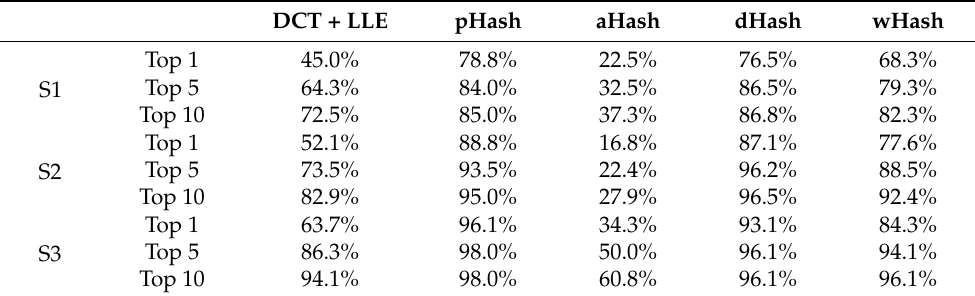
Table A8. Correct matches results for database vs. TS2 comparison—256 bits.